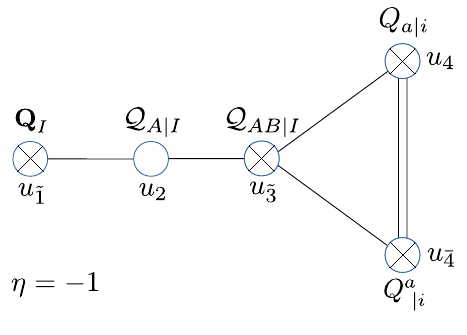
Figure 6 . Chain of Q functions corresponding to the (cid:17) = (cid:0) 1 grading of the Bethe Ansatz. We have marked this equation with the symbol F to point out that it is a fermionic-type 1 Q-system relation, based at the (cid:12)rst node of the Dynkin diagram. This equation